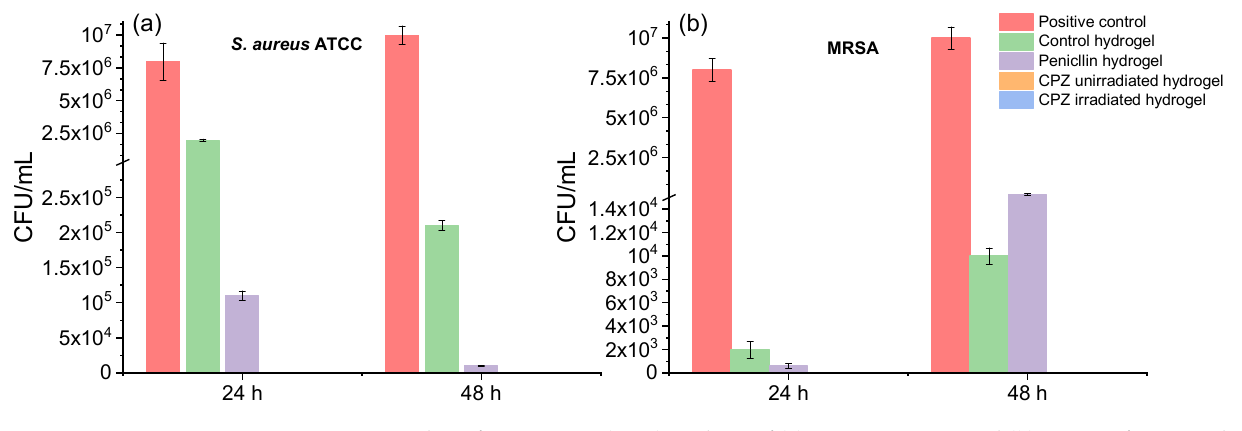
Figure 11. Colony forming unit (CFU) analysis of ( a ) S. aureus ATCC and ( b ) MRSA after 24 and 48 h treatment with hydrogels loaded with unirradiated CPZ, 30 min irradiated CPZ, and penicillin; the positive control is represented by pure bacterial culture in the absence of hydrogels; data expressed as mean ± SD, n = 3.